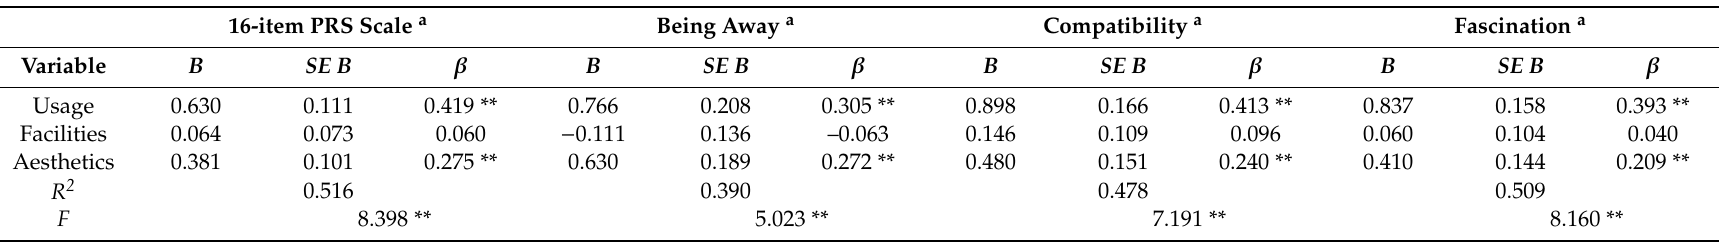
Table 3. Summary of multiple linear regression analyses for variables predicting 16-item PRS scale, being away, compatibility, and fascination ( N =